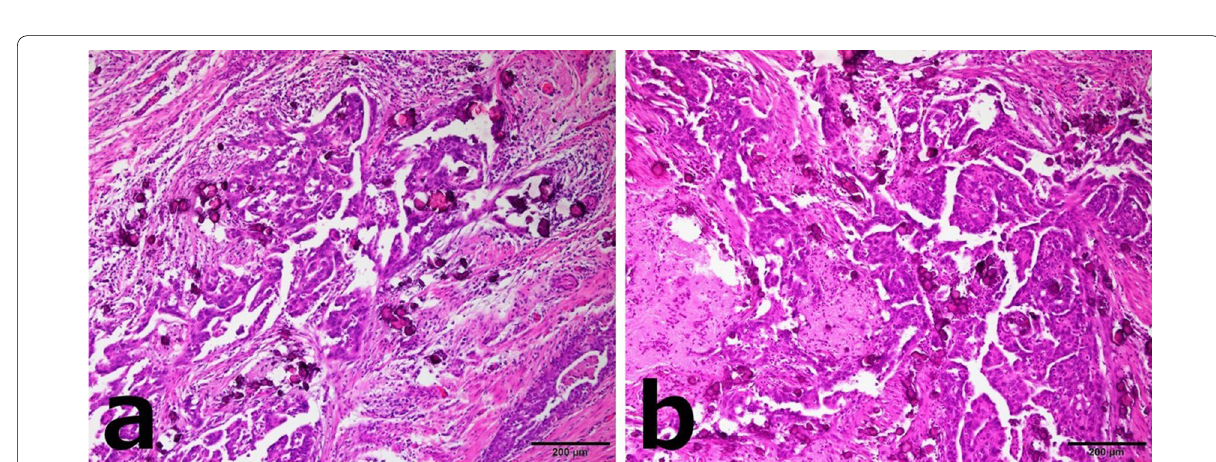
Fig. 8 Case 2: microscopic findings of the resected specimen (hematoxylin/eosin staining). a Ovarian histopathology. b Omental histopathology. Examination revealed the proliferation of adenocarcinoma cells with a basophilic cytoplasm and strong atypical nuclei